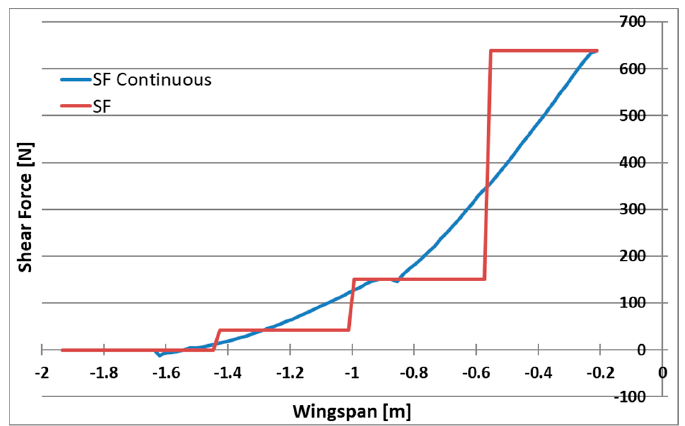
Figure 7. Shear force distribution for continuous and applied loading.